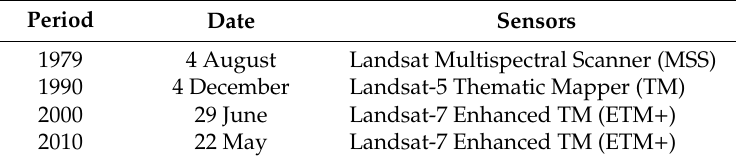
Table 2. Description of the four-periods for the Landsat satellite images.